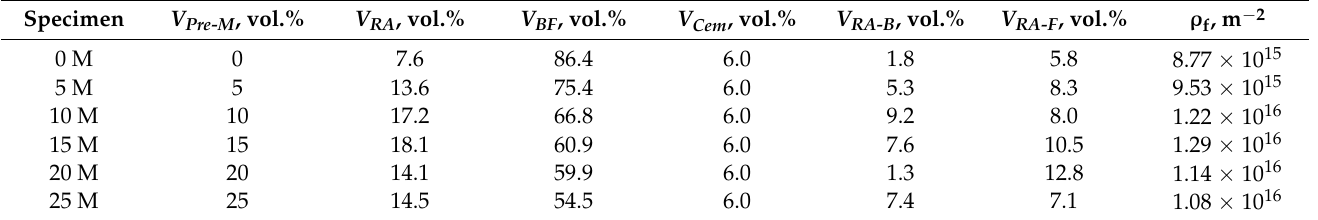
Table 1. The volume fraction of each phase and the dislocation density in ferrite phase ( ρ f ) of specimens with different treatment processes.